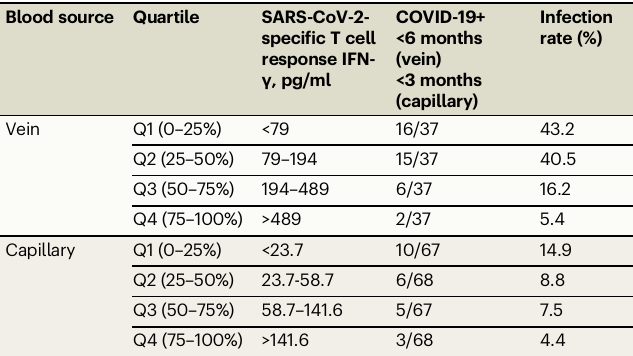
Table 2 | Absolute risk of SARS-CoV-2 infection within 6 months of blood